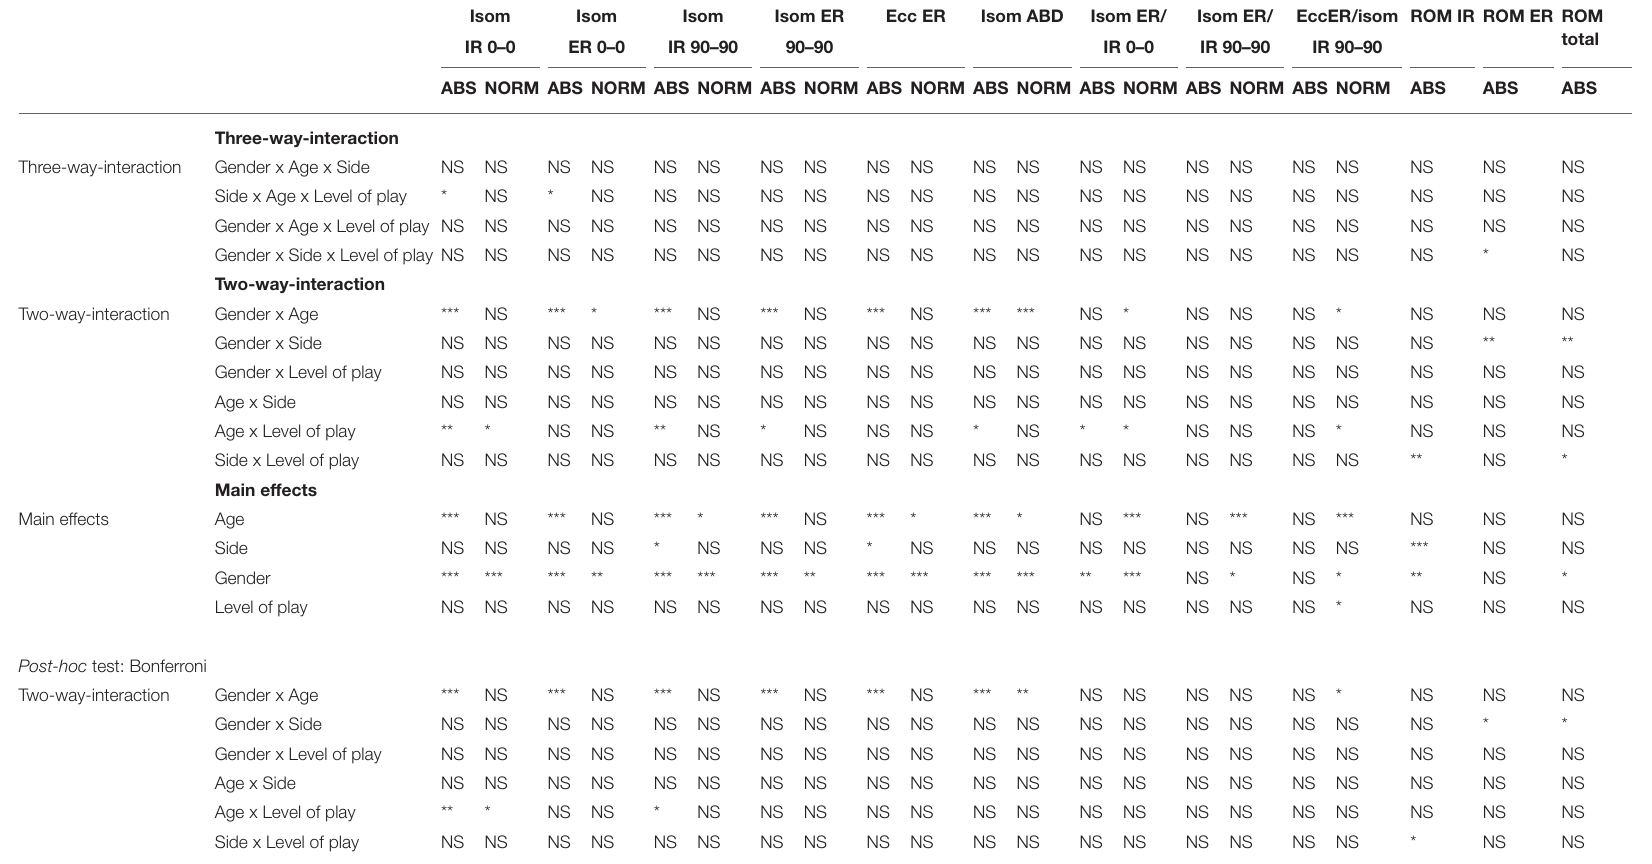
TABLE 5 | Results from the repeated measures ANOVA for all